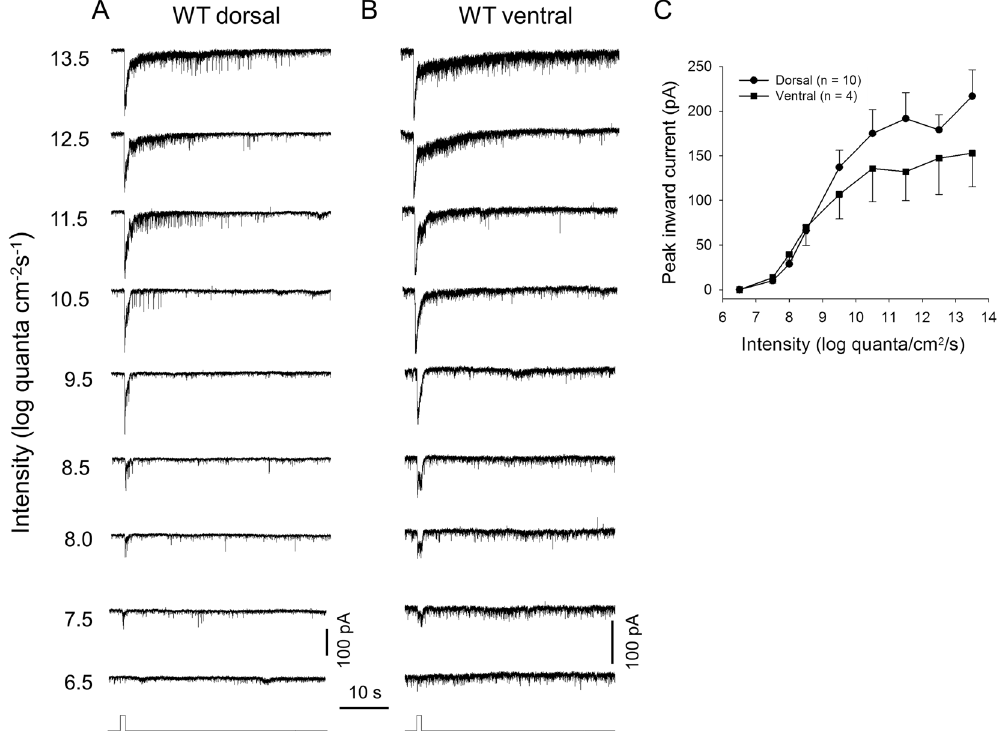
Figure 1. Light-evoked excitatory postsynaptic currents (EPSCs) of dorsal and ventral DACs in dark-adapted wild-type retinae. Light-evoked EPSCs of a dorsal DAC ( A ) and a ventral DAC ( B ) in response to a series of increasingly bright white light pulses (1-s duration) ranging from 6.5 to 13.5 log quanta/cm 2 /s. Stimulation bar shows timing of light pulse. ( C ) Intensity-response profiles showing the average peak amplitudes of DAC light- evoked EPSCs as a function of the light intensity. Closed circles: dorsal DACs; closed squares, ventral DACs. Each data point shows the average and standard error (SE) of multiple